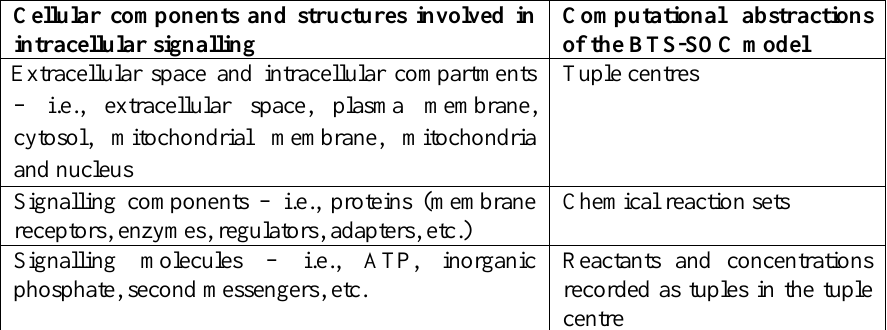
Table I: Mapping cellular components.